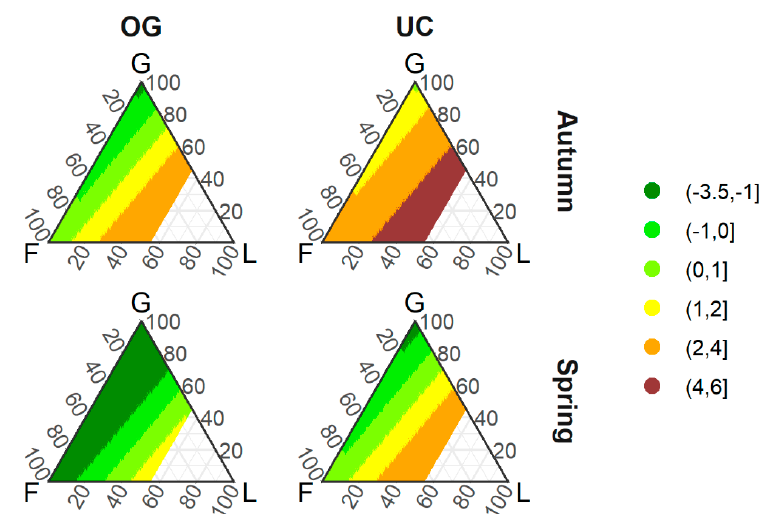
Table 3). Moreover, PFT composition of the herbaceous layer drove significantly N 2 O fluxes, being the most parsimonious and explanatory model an identity model (Equation (2)), with the presence of legumes significantly enhancing N 2 O emissions (legumes effect, t = 2.49, p = 0.02, Table 3 and Figure 3).